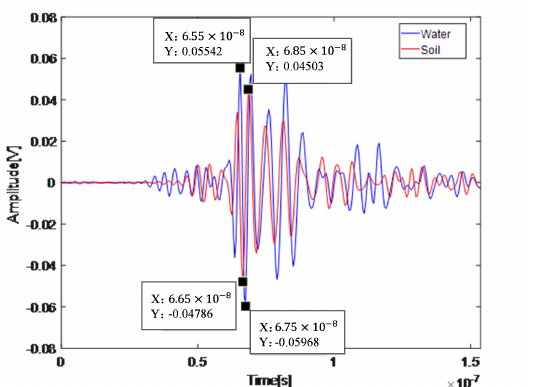
Figure 8. The A − Scans of water and soil, where the peak-to-peak values are extracted for permittivity